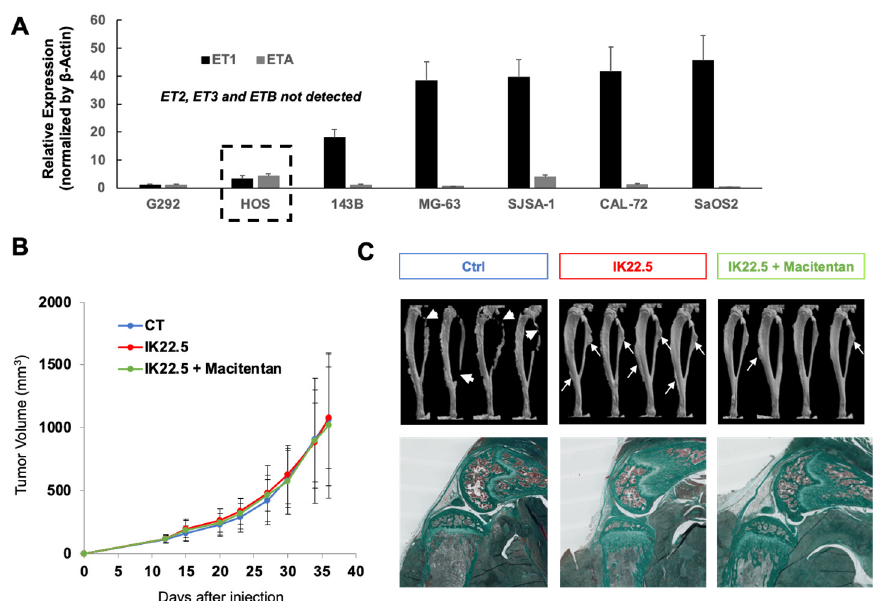
Figure 4. Macitentan strengthened the bone protective effect of RANKL blocking antibody (IK22.5) injections in the human HOS orthotopic mouse model. RT-qPCR analyses of endothelins and their receptor expressions in seven human osteosarcoma cell lines showed that only ET1 and ETA were detected, with a higher ETA expression compared to ET1 in the HOS cell line ( A ). Injections of IK22.5 RANKL blocking antibody alone or in combination with macitentan treatment, in the orthotopic osteosarcoma model corresponding to NRMI Nude mice injected with HOS cells, had no impact on tumor growth ( B ) but made it possible to protect bone from the tumor-induced resorption seen in untreated controls (arrow-heads in ( C )). Adding a treatment with macitentan to IK22.5 injections also reduced tumoral osteoid tissue formation (arrows in ( C )) and enlargement of the trabecular bone as seen in the histological sections ( C ).